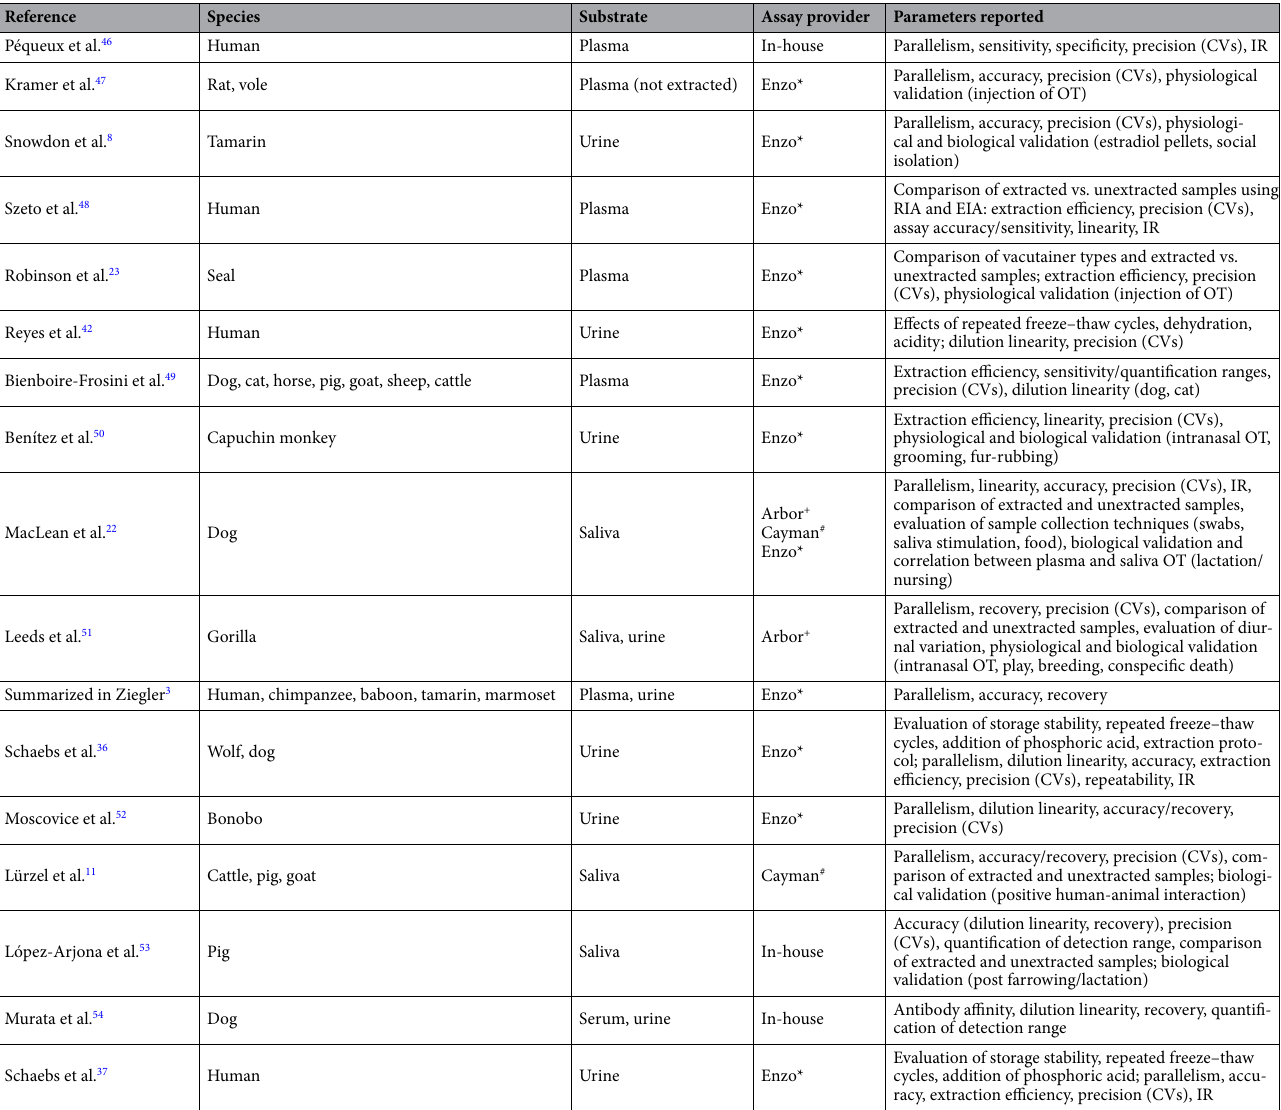
Table 1. Overview of studies reporting validations of oxytocin EIAs using peripheral substrates (blood, urine, saliva). *Enzo Life Sciences, Assay Designs Inc., Ann Arbor, MI, USA, https:// www. enzol ifesc iences. com, + Arbor Assays Headquarters, Ann Arbor, MI, USA, https:// www. arbor assays. com, # Cayman Chemical, Ann Arbor, MI, USA, https:// www. cayma nchem.